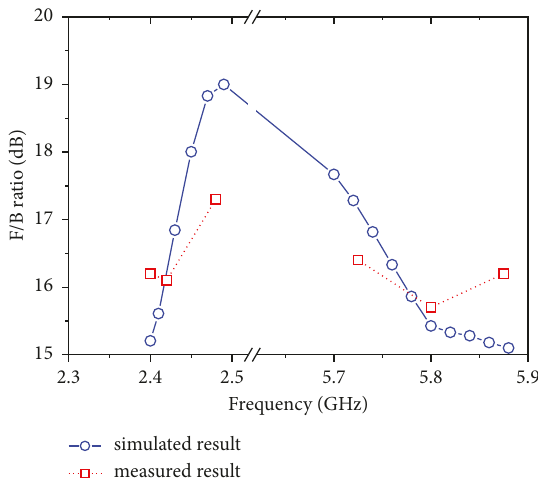
Figure 7: Simulated and the measured F/B ratio over the operating bands of the proposed directional antenna.